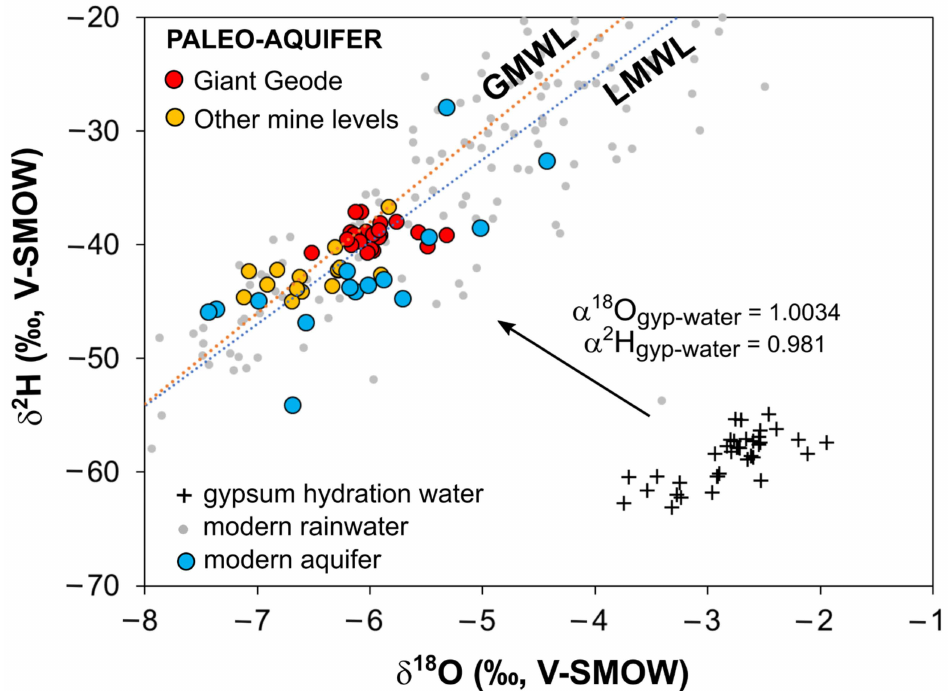
Figure 2. δ 18 O and δ 2 H values of gypsum hydration water and calculated paleo-aquifer water (mother solution) at the time of gypsum precipitation. The δ 18 O and δ 2 H of the paleo-aquifer water were obtained from those of gypsum and after applying known isotope fractionation factors (see main text). The isotopic composition of the modern aquifer [23] and the values of rainfall in this region (local meteoric water line, LMWL) (from the International Atomic Energy Agency stations at Almer í a and Murcia; [24]) are displayed for